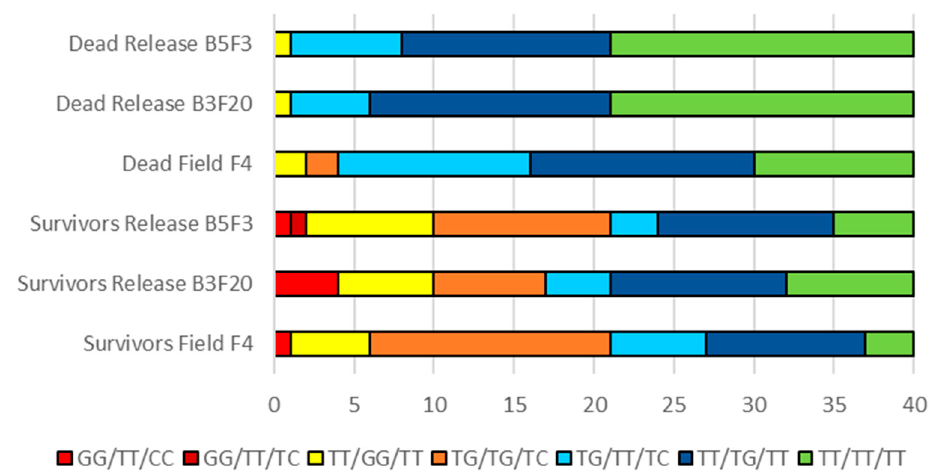
Figure 3. Proportion of each Vssc genotype in 40 samples of dead and surviving Aedes aegypti females from bioassays with deltamethrin (type II pyrethroid) (0.03%). Mutations listed in order 1016/1534/989 (in all cases T = wildtype).